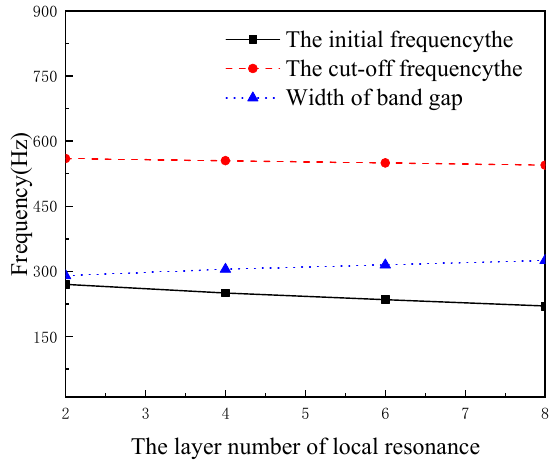
Figure 4. The effect of the local resonant layers on the band gap. Figure 4 demonstrates that the initial frequency and the cut-off frequency of the bandgap are moving to lower frequency, with the initial frequency decreasing from 270 Hz to 220 Hz and the decreasing degree of the initial frequency being greater than the degree of the cut-off frequency. Therefore, the width of band gap increases from 290 Hz to 325 Hz. On the basis of period pipeline model of the phononic crystal, only the number of local resonant layers is changed and other parameters are unchanged, and the acceleration damping performance of the model is calculated when the number of local resonant layers is 2, 4, 6 and 8 layers, as shown in Figure 5. As can be seen from the figure, with the increase of the number of local resonant layers of the pipeline, the damping performance of the pipeline is becoming increasingly better, and the effect of damping is improved by 18.3 dB.